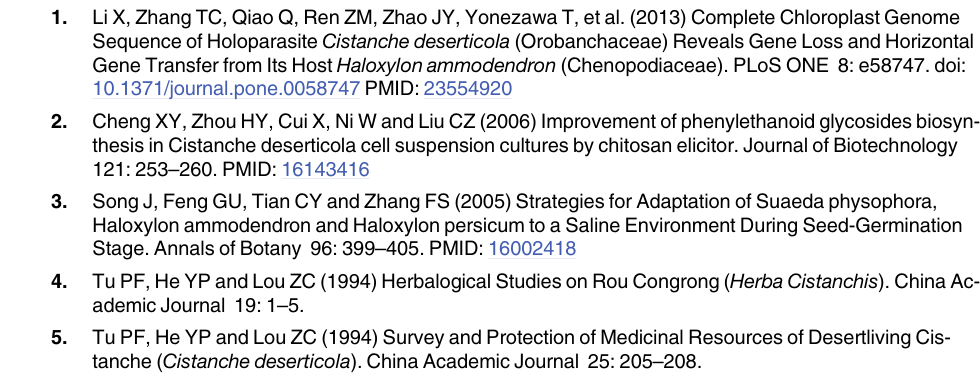
known PAL gene and assembled potential PAL sequences in C . deserticola